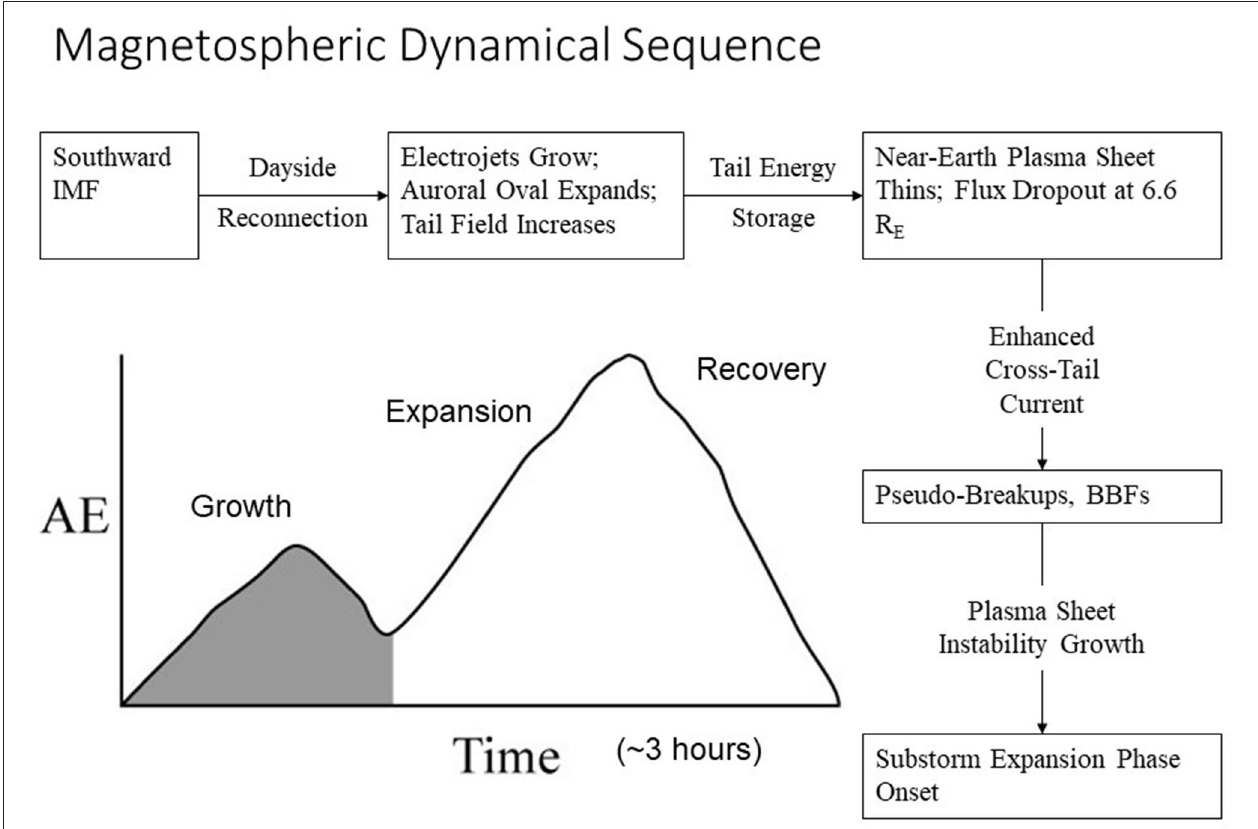
FIGURE 5 | A notational sketch of an isolated substorm as seen in a time series of auroral electrojet (AE) values vs. time. The boxes in the flow chart around this schematic describe the key, repeatable physical phenomena occurring during substorms. BBFs are bursty bulk flows of plasma. These are localized, high-speed particle transport